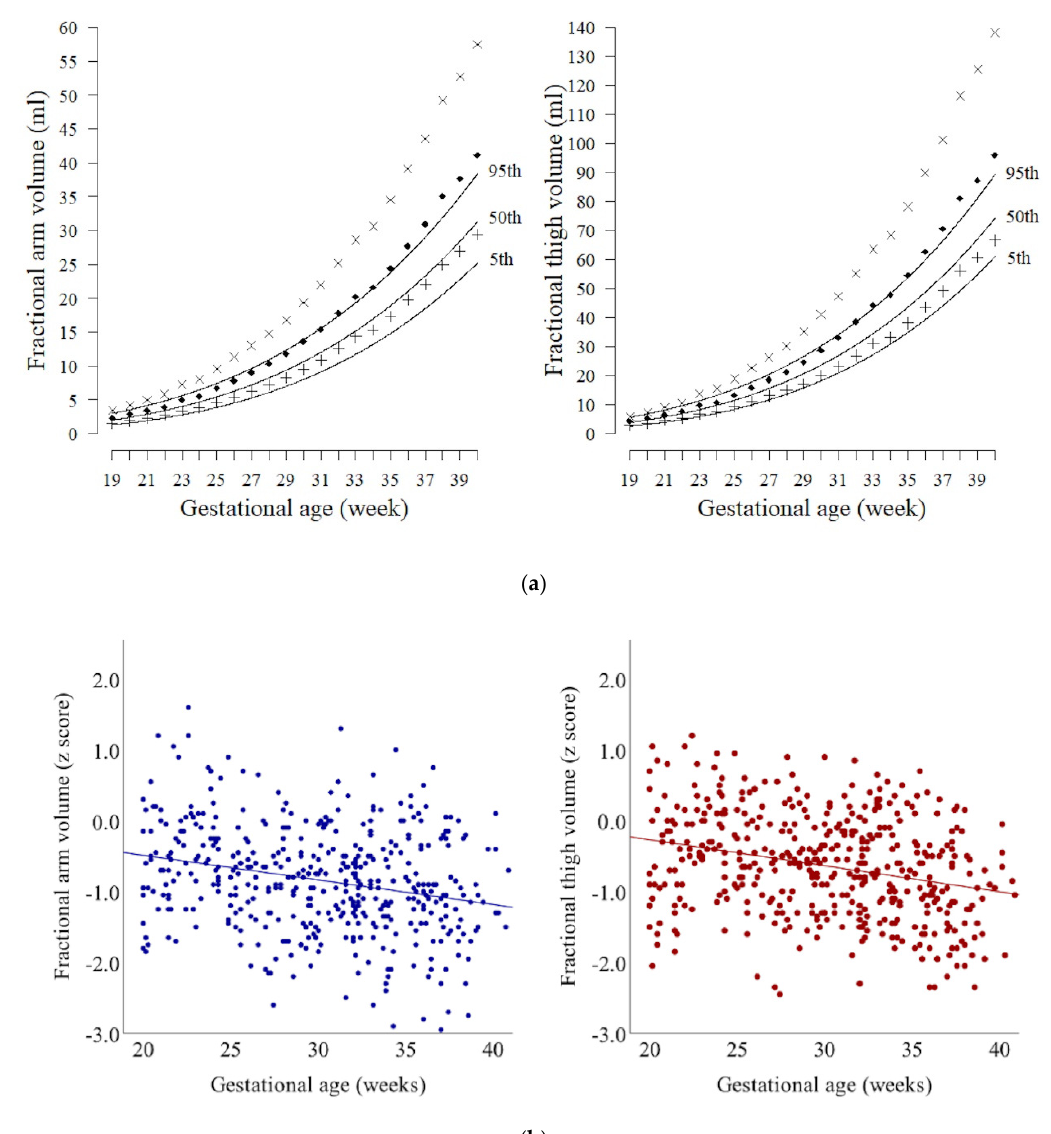
Figure 2. ( a ) Growth curve of fractional arm volume and thigh volume in the present cohort (continuous lines) and that of previous report [12] (interrupted lines; ×, 95th; ◆ , 50th; +, 5th percentile). ( b ) The z-scores of arm volume (AVol) and thigh volume (TVol) across gestation, with the linear regression lines, which are negatively significant ( p < 0.0001).